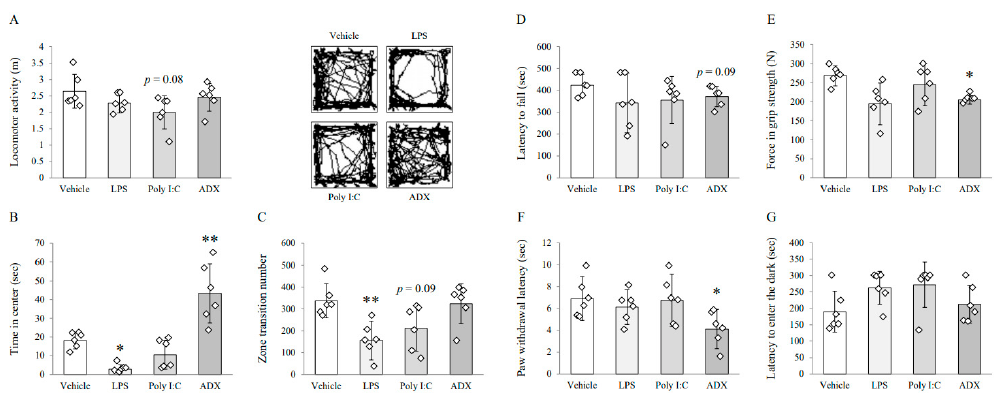
Figure 1. Behavioral tests for symptoms of chronic fatigue syndrome (CFS) among mice